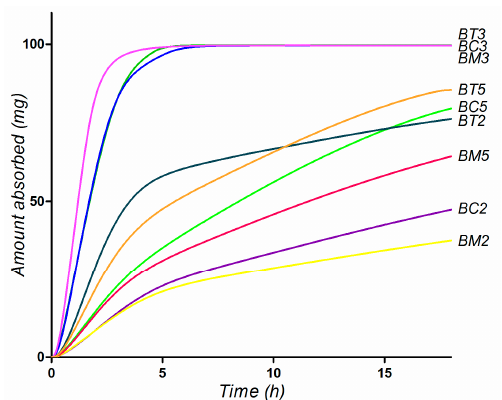
Figure 9. Simulated absorption profiles for the tested compounds, considering oral administration of 100 mg compounds as aqueous suspension.